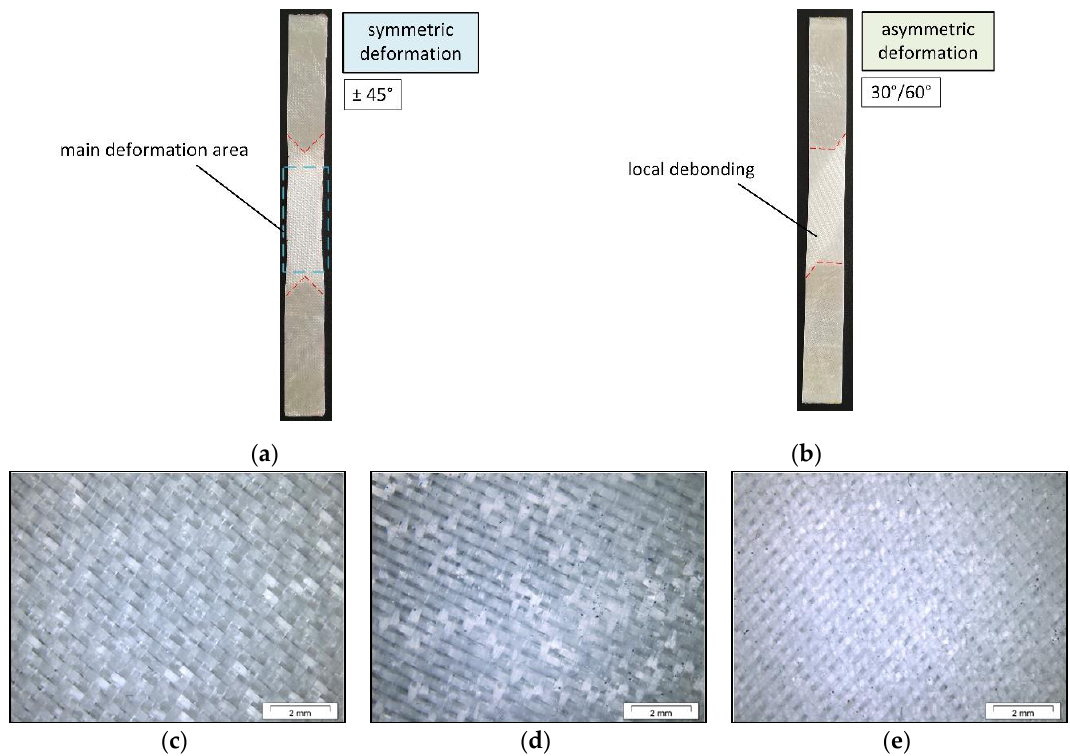
Figure 6. Optical damage analysis of GF-PDMS composites from tension tests with ±45° fiber orientation ( a ) and 30°/60° ( b ) oriented compared tension-twist load-coupling tests with ±45° composite: in initial state ( c ), after load-coupling test ( d ) and after tension tests ( e ).